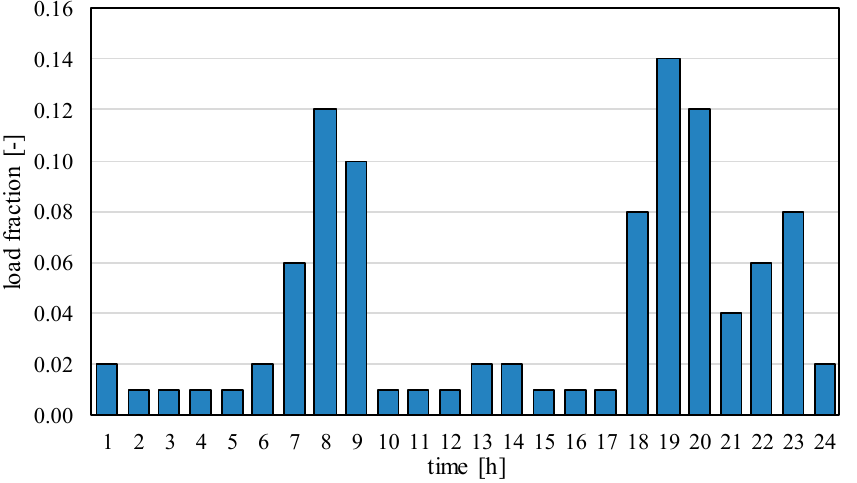
Figure 6. Daily load curves for the hot water need.